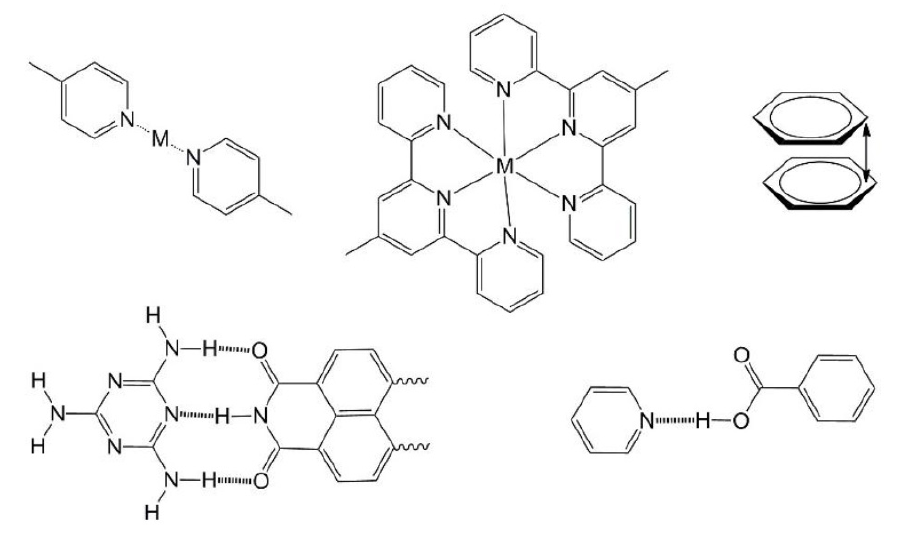
Figure 3. Typical structure-directing motifs used in self-assembled systems. Top: coordination of pyridyl nitrogen atoms to transition metal ions (M), terpyridyl coordination assembly, aromatic π - π stacking. Bottom: hydrogen bonding motifs of melamine/naphthalene